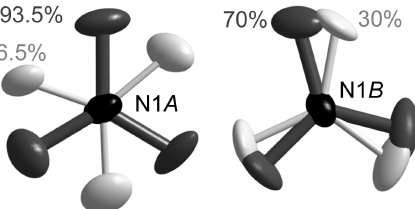
Figure 7 The disorder models used in the refinement of the NO 3 (cid:2) anion at 85 K in the q 1 = (0, 1 , 1 ) superstructure. 2 2